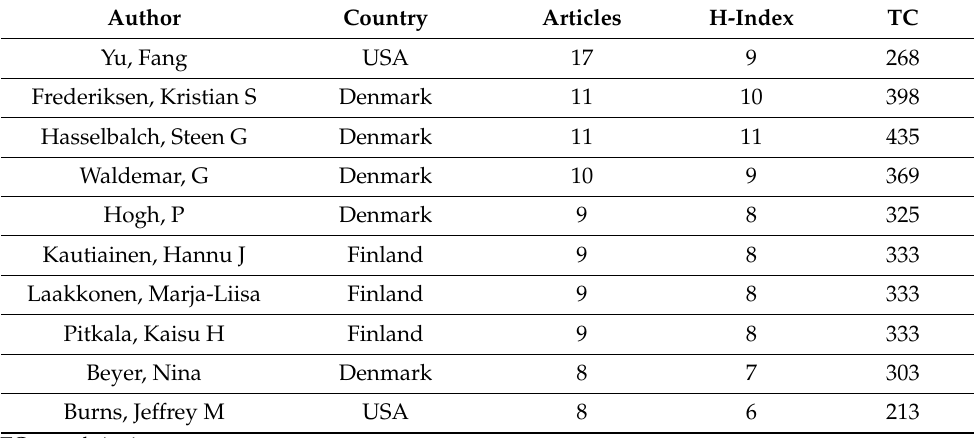
Table 4. The top 10 authors contributing to AD exercise